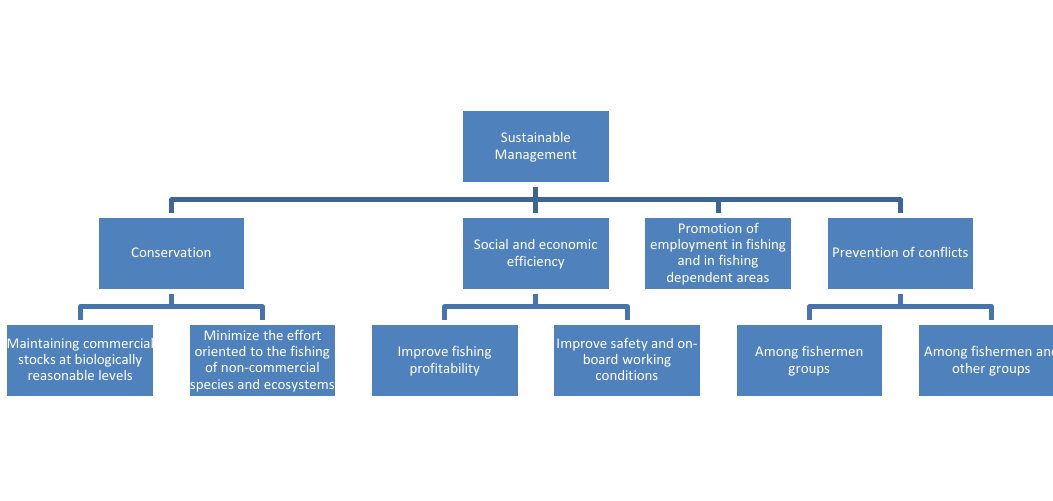
Figure 1 . Fishery management objectives. Source: own